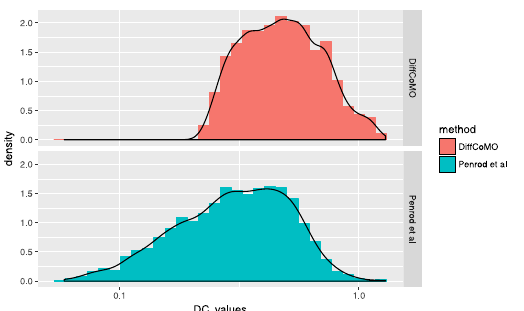
Figure 7. The upper pane of the figure shows the distribution of DC _ values of all the gene pairs belonging to the differentially coexpressed modules obtained from DiffCoMO. The lower pane shows the same for the method proposed in ref. 22.